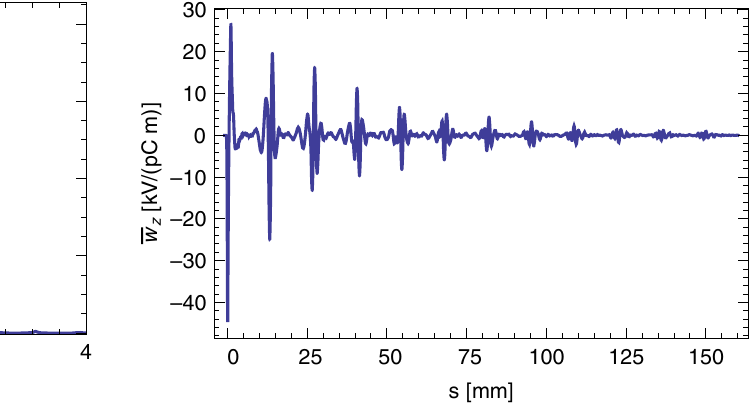
FIG. 11. The real part of the longitudinal impedance for the beam moving on axis of a double plate dechirper with half aperture a ¼ 0 . 7 mm, obtained by taking the Fourier transform of the numerically obtained wake of Fig. 10.